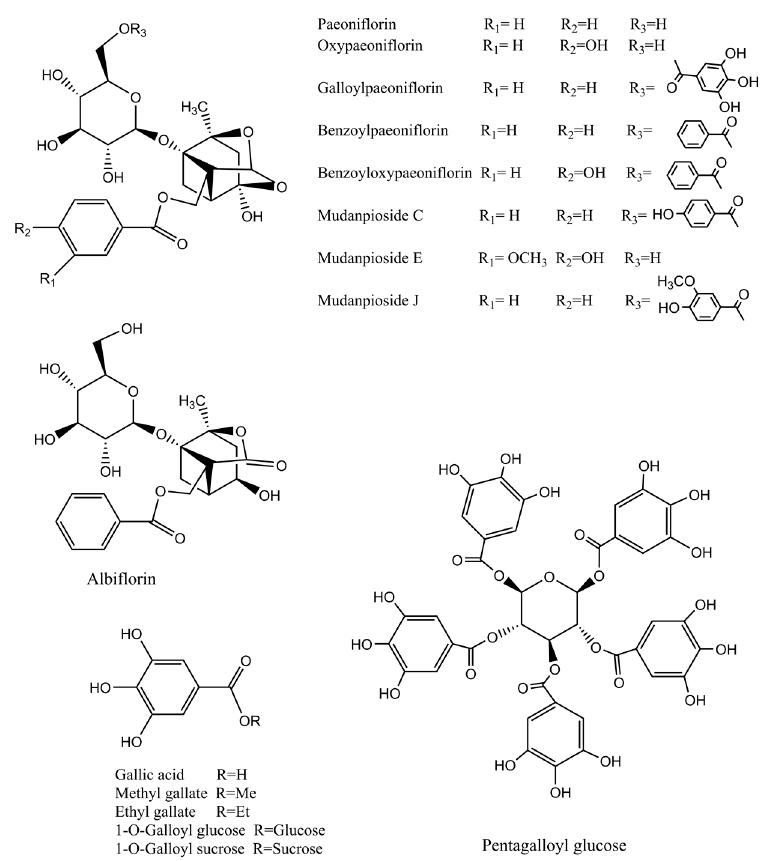
Figure 2. Chemical structures of the main identified constituents in the extracts from P. delavayi root.